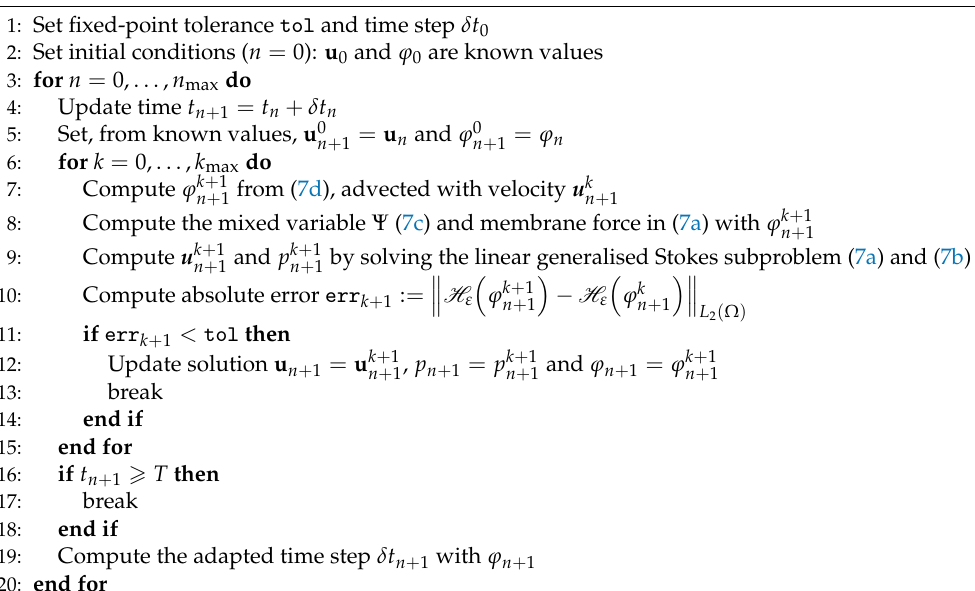
Algorithm 1 Fluid/vesicle coupling